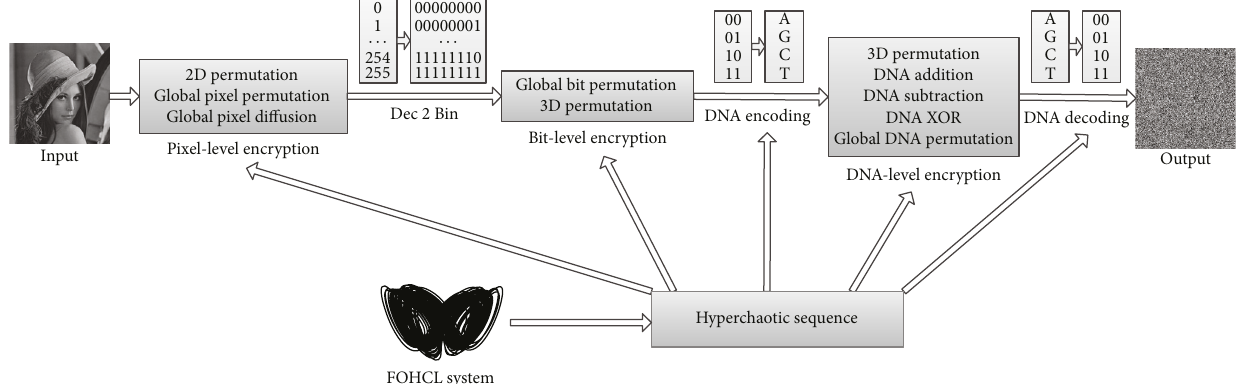
Figure 2: The flowchart of the proposed FOHCLDNA